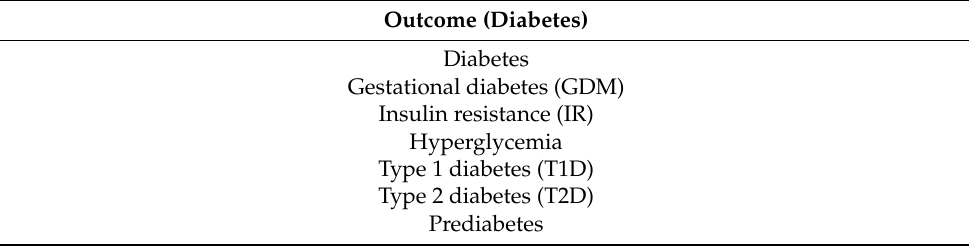
Table 2. Search terms for diabetic